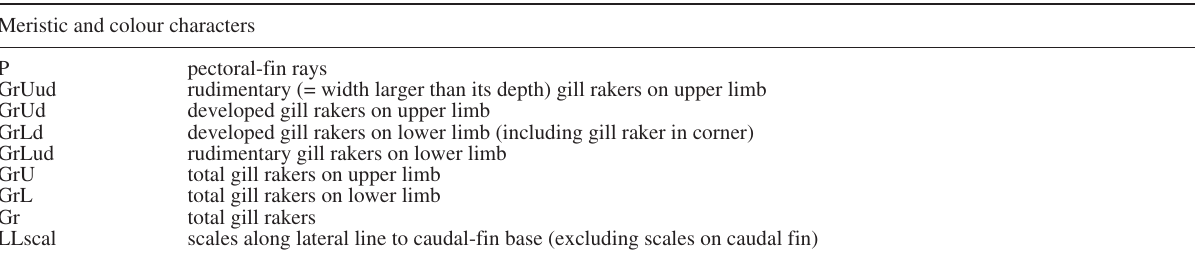
Table 1. – Abbreviation and description of morphometric and meristic characters Morphometric characters SL standard length, distance between snout tip and caudal fin base at mid-body BODYDD body depth at first dorsal-fin origin BODYDA body depth at anal-fin origin HALFDD half body depth (from lateral line downwards) at first dorsal fin origin HALFDA half body depth (from lateral line downwards) at anal fin origin CPDD caudal-peduncle depth, minimum depth anterior to caudal dorsal origin CPDW caudal-peduncle width at position of CPDD measurement HEAD1 maximum head depth, vertical distance at ventral edge of operculum HEAD2 head depth across a vertical midline through eye SUBORB suborbital depth - distance between lower edge of orbit to ventral midline of head INTORB interorbital length - least distance between upper bony edges of orbits HEADL head length - distance between snout tip to posteriormost margin of operculum SNOUTL snout length -distance between snout tip to anterior margin of orbit PORBL postorbital length, distance between posterior edge of orbit and posterior margin of operculum ORBITL orbit length, horizontal fleshy orbit diameter ORBITD orbit depth, vertical fleshy orbit diameter UJAWL upper-jaw length - distance between symphysis and posterior end of upper jaw LJAWL lower-jaw length - distance between symphysis of lower jaw and posterior end of upper jaw SNOUTW snout width – least distance between hinder margins of upper jaw, with closed mouth BARBL barbel length BARBW maximum barbel width, horizontal width measured at base of soft part of barbel SD1 first pre-dorsal length - distance between snout tip to origin of first dorsal fin SD2 second pre-dorsal length - distance between snout tip to origin of second dorsal fin D1D2 interdorsal distance - distance between last spine of first dorsal and first ray of second dorsal fin CPDL caudal-peduncle length - distance between last anal ray and ventral origin of caudal fin SANL pre-anal length - distance between snout tip to origin of anal fin SPEL pre-pelvic length - distance between snout tip to origin of pelvic fin SPEC pre-pectoral length - distance between snout tip to dorsal origin of pectoral fin D2ANL second dorsal-fin depth - distance between origin of second dorsal fin to origin of anal fin D1PELV pelvic-fin depth - distance between origin of first dorsal fin to origin of pelvic fin D1PEC pectoral-fin depth - distance between origin of first dorsal fin to dorsal origin of pectoral fin D1B length of first dorsal-fin base D2B length of second dorsal-fin base CAUH distance between dorsal caudal-fin origin and upper caudal-lobe tip ANALB length of anal-fin base ANALH distance between anal-fin origin and anal-fin anterior tip (= to tip of first anal ray) PELVL distance between pelvic-fin origin and pelvic-fin tip PECTL distance between pectoral-fin dorsal origin and pectoral-fin tip PECTW width of pectoral-fin base D1H first dorsal-fin height - distance between first dorsal-fin origin and first dorsal-fin anterior tip (= to tip of first long dorsal-fin spine) D2H second dorsal-fin height - distance between second dorsal-fin origin and second dorsal-fin anterior tip (= to tip of second dorsal-fin ray) Meristic and colour characters P pectoral-fin rays GrUud rudimentary (= width larger than its depth) gill rakers on upper limb GrUd developed gill rakers on upper limb GrLd developed gill rakers on lower limb (including gill raker in corner) GrLud rudimentary gill rakers on lower limb GrU total gill rakers on upper limb GrL total gill rakers on lower limb Gr total gill rakers LLscal scales along lateral line to caudal-fin base (excluding scales on caudal